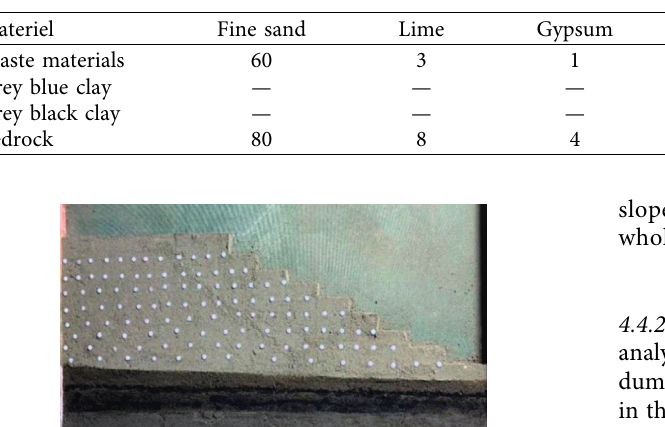
Figure 6: Simplified diagram of PM3 model. Table 3: Model material allocation ratio (%).